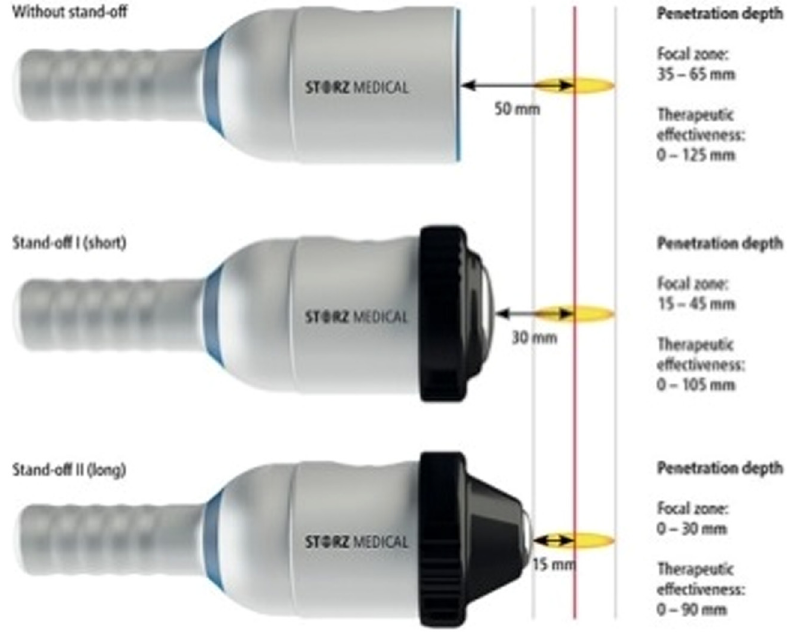
Figure 2: Characteristics of the transducer.